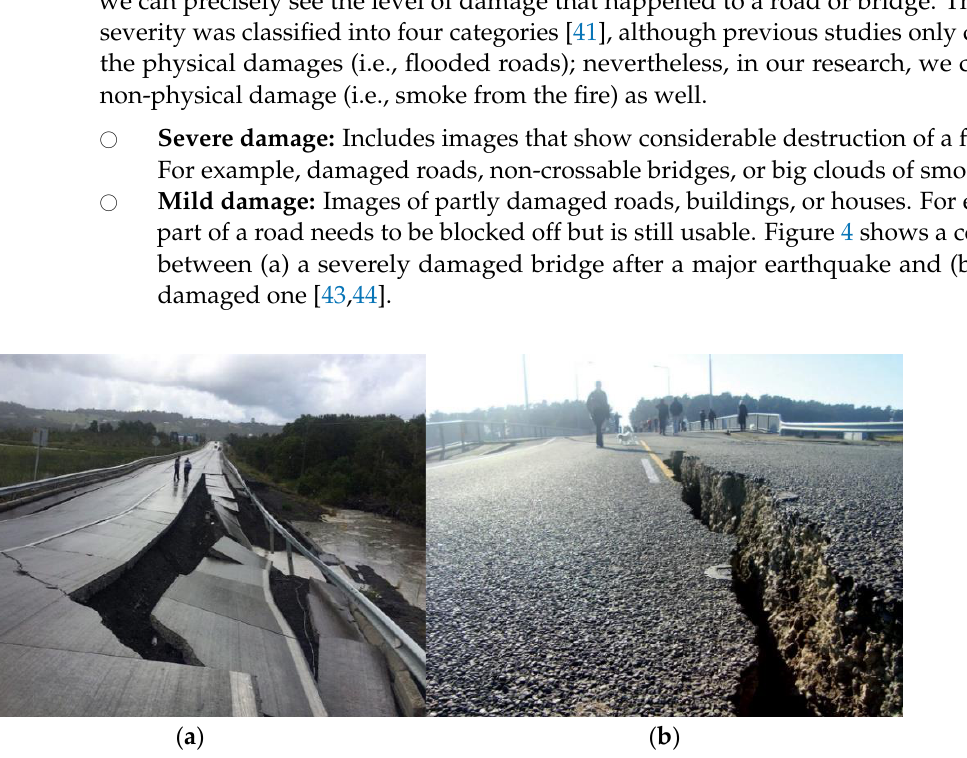
Figure 4. ( a ) Depicts a severely damaged bridge after an earthquake in New Zealand. ( b ) Depicts a mildly damaged bridge after an earthquake in